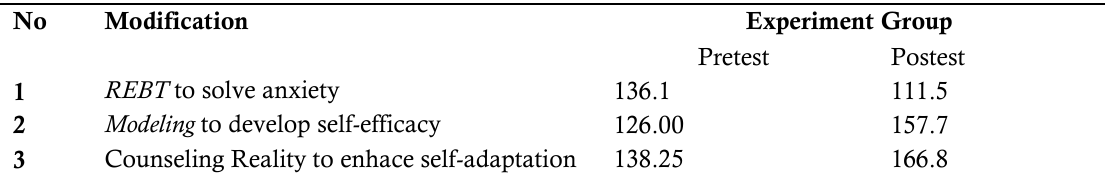
Table 2. Comparison between Pretest and Posttest with the use of One